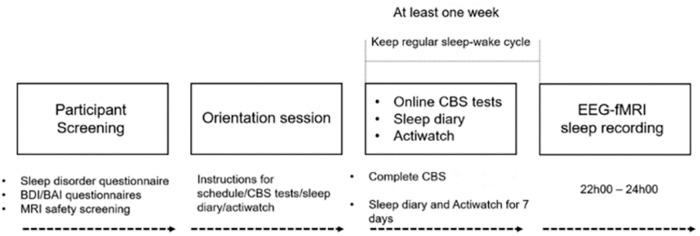
Experimental procedure of the study. Participants underwent initial screening to exclude any signs of sleep disorders, unusual sleep habits, or other health-related ineligibility and MRI compatibility. Eligible participants visited the sleep lab for the orientation session at least a week prior to the EEG–fMRI sleep recording night, in which participants were given detailed instructions about the study procedure, CBS tests, sleep diary, and actiwatch. All participants completed the CBS tests online and kept a regular sleep-wake cycle for at least 1 week prior to the sleep recording. Compliance with this schedule was assessed using both sleep diaries and wrist actigraphy. Participants who met these requirements were scheduled for the EEG–fMRI sleep recording session. MRI scanning started at 21h00, and lights out was from 22h00 to as late as 24h00.